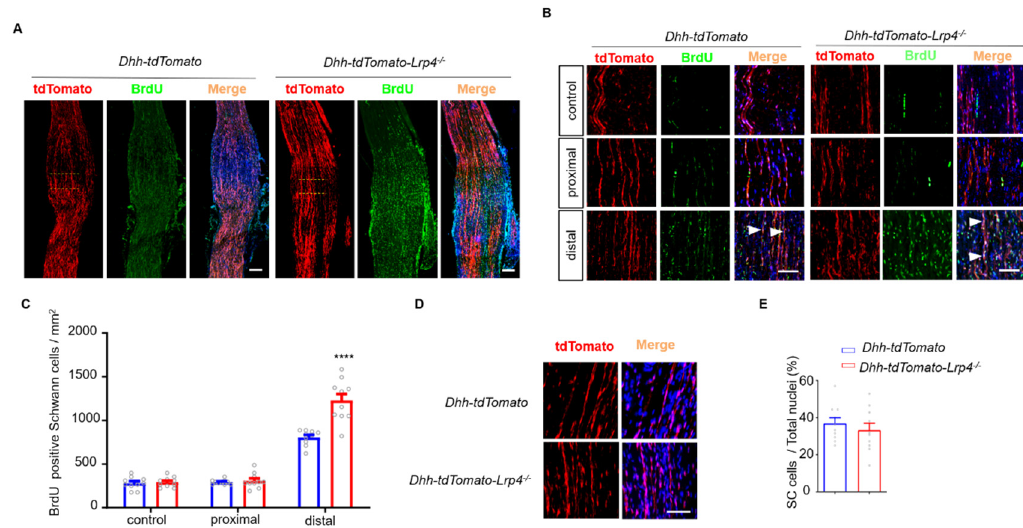
Figure 5. The proliferation of SCs in Lrp4 cKO mice was enhanced after nerve damage. ( A ) Immunostaining of the sciatic nerve of newly formed SCs at 5 dpc. Scale bar = 200 μ m. ( B ) Representative images of the sham operation control and proximal and distal crushed nerves. The white arrows indicate the costaining of Dhh-tdTomato and BrdU. Scale bar = 50 μ m. ( C ) Enhanced proliferation of SCs in Dhh-tdTomato-Lrp4 -/- mice (1229.0 ± 75.2) sciatic nerves compared with Dhh-tdTomato mice (806.6 ± 27.6) after nerve crush. **** p < 0.0001, control and cKO, n = 10 slices, 3 mice/group. ( D ) Representative images of mSCs under normal conditions. Scale bar = 50 μ m. ( E ) The mSC numbers under normal conditions did not differ between Dhh-tdTomato and Dhh-tdTomato-Lrp4 -/- mice. Control, n = 20 slices; cKO, n = 21 slices, 3 mice/group. All the data are presented as the mean ± SEM.